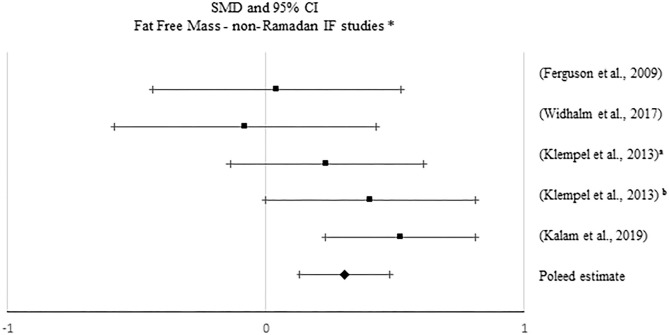
Forest plot of the effects from a random-effects and fixed-effects, respectively, meta-analysis shown as standardized mean difference with 95% confidence intervals on relative fat mass (FM) for all studies and only Ramadan IF studies. For each study, the square represents the standardized mean difference between pre-post data intervention and control groups, with the horizontal line intersecting it as the lower and upper limits of the 95% confidence interval. Forest plot of the effects from a random-effects and fixed-effects, meta-analysis shown as standardized mean difference with 95% confidence intervals on relative FM for all studies, only Ramadan IF studies and only non-Ramadan IF studies. For each study, the square represents the standardized mean difference between pre- and post-intervention time points. The rhombi represents the pooled estimated standardized mean difference. *Pre-post tests, IF intervention; **Pre-post tests, IF intervention vs. control.